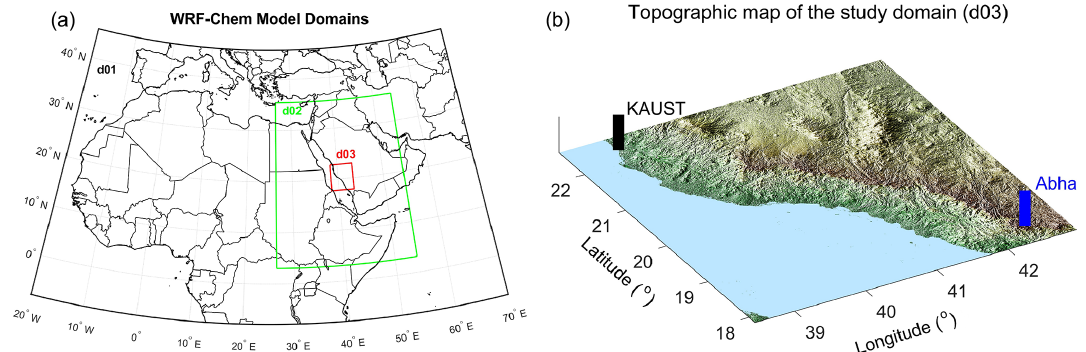
Figure 1. Study area showing the nested domains d01, d02, and d03 used to conduct WRF-Chem model simulations (a) and a zoom-in topographic map of domain d03 over the Red Sea coast (b)